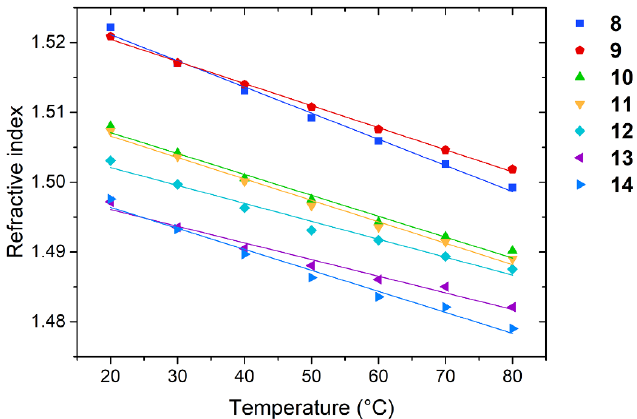
Figure 3. Refractive indices of ILs 8 – 14 in a temperature range from 20 to 80